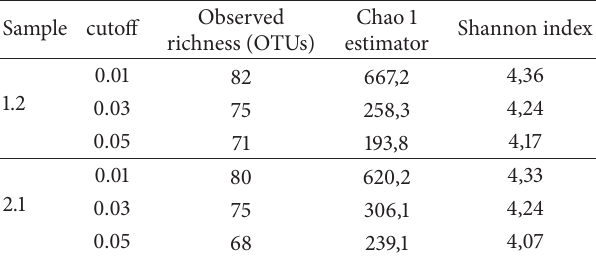
Table 2: Alpha diversity indices for the two samples at different cutoff values.